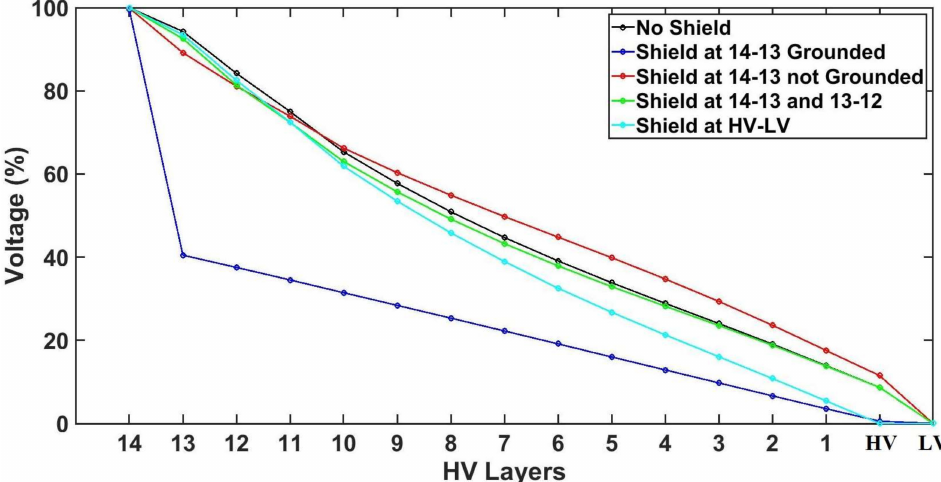
Figure 25. The e ff ect of shield on initial voltage distribution for SLI.